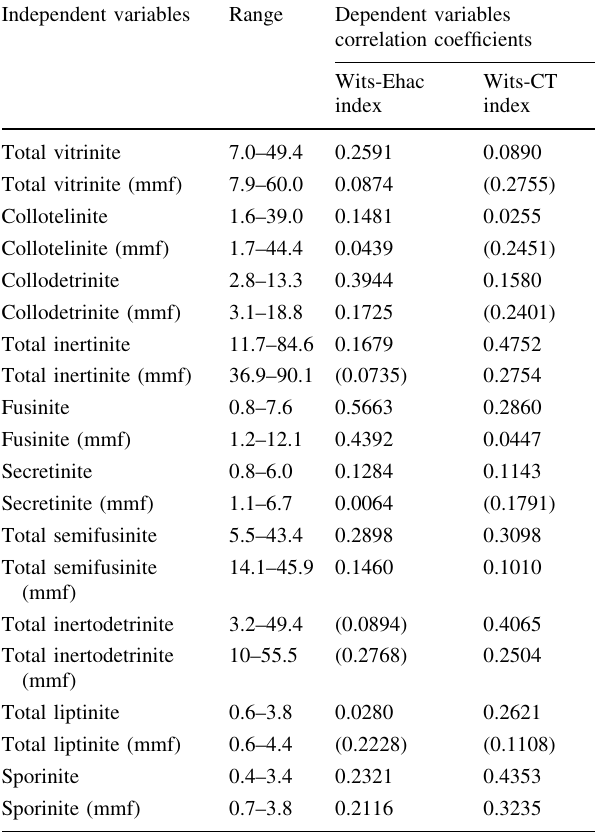
Table 3 Relationships between independent (petrographic analysis, vol%) and dependent variables for coal samples Independent variables